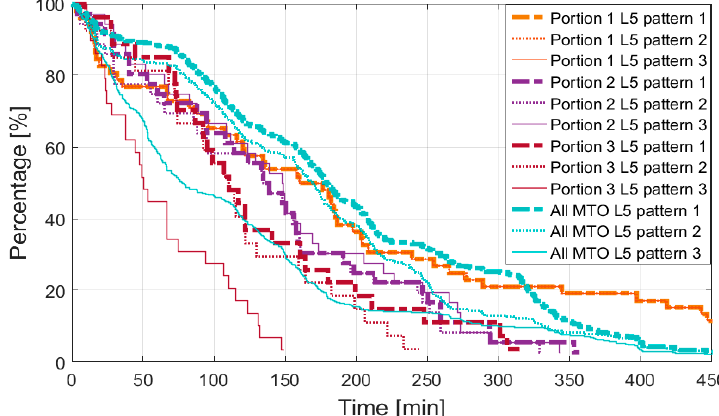
Figure 25. GDOP in log scale during the assumed MTO.